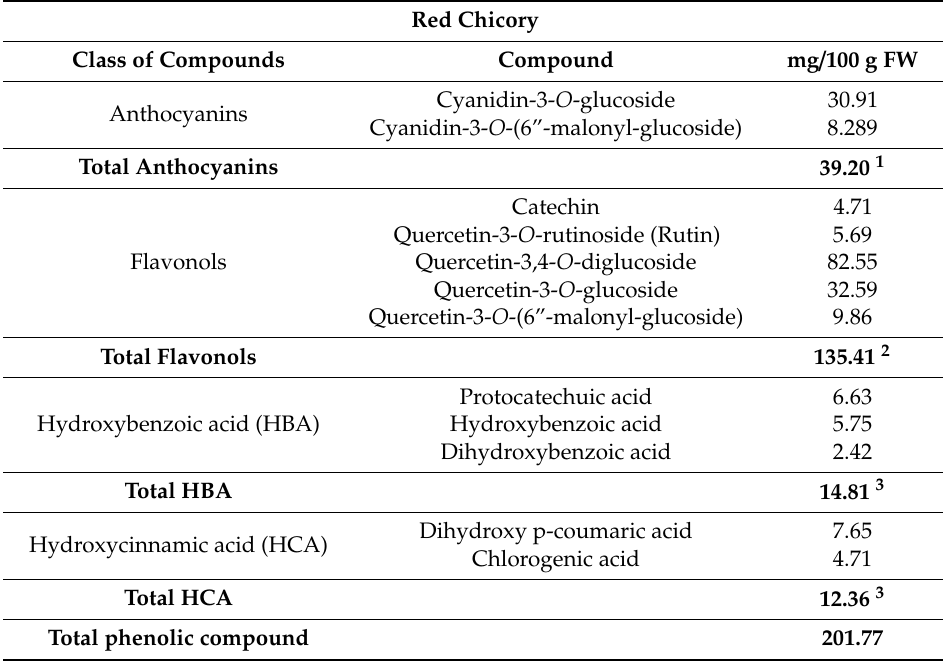
Table 8. Total polyphenolic compounds content in red